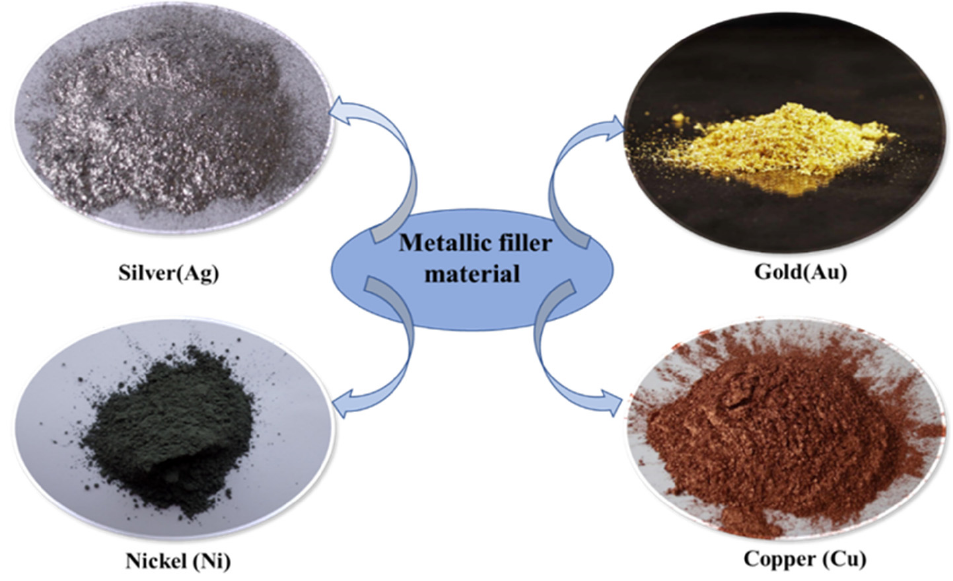
Figure 8. Commonly used thermally conductive metallic filler.